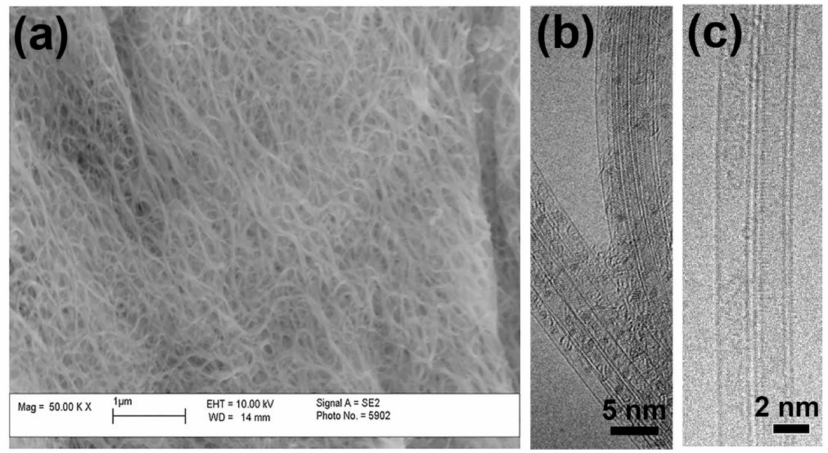
Figure 3. ( a ) The SEM image of the pristine SWCNTs, ( b ) the TEM image of NiCp 2 -filled SWCNTs annealed at 200 ◦ C, ( c ) the TEM image of DWCNTs obtained by annealing of CoCp 2 -filled SWCNTs at 750 ◦